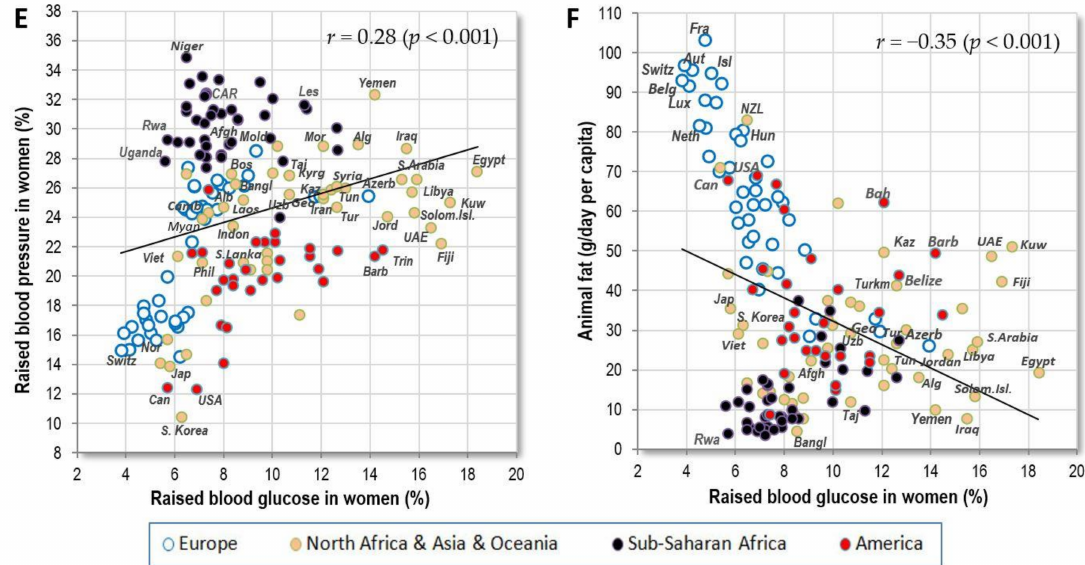
Figure 7. ( A ) Relationship between women’s raised blood glucose (%; WHO, 2010) and the mean BMI in women (WHO, 2010); ( B ) Relationship between women’s raised blood glucose (%; WHO, 2010) and the mean consumption of cereals (g/day per capita; FAOSTAT, 1993–2011); ( C ) Relationship between women’s raised blood glucose (%; WHO, 2010) and the mean proportion of carbohydrate energy from cereals (% CC energy) in the diet (FAOSTAT, 1993–2011); ( D ) Relationship between women’s raised blood glucose (%; WHO, 2010) and the mean total energy intake (kcal/day, FAOSTAT, 1993–2011); ( E ) Relationship between women’s raised blood glucose (%; WHO, 2010) and women’s raised blood pressure (%; WHO, 2010); ( F ) Relationship between women’s raised blood glucose (%; WHO, 2010) and the mean consumption of animal fat (g/day per capita; FAOSTAT,